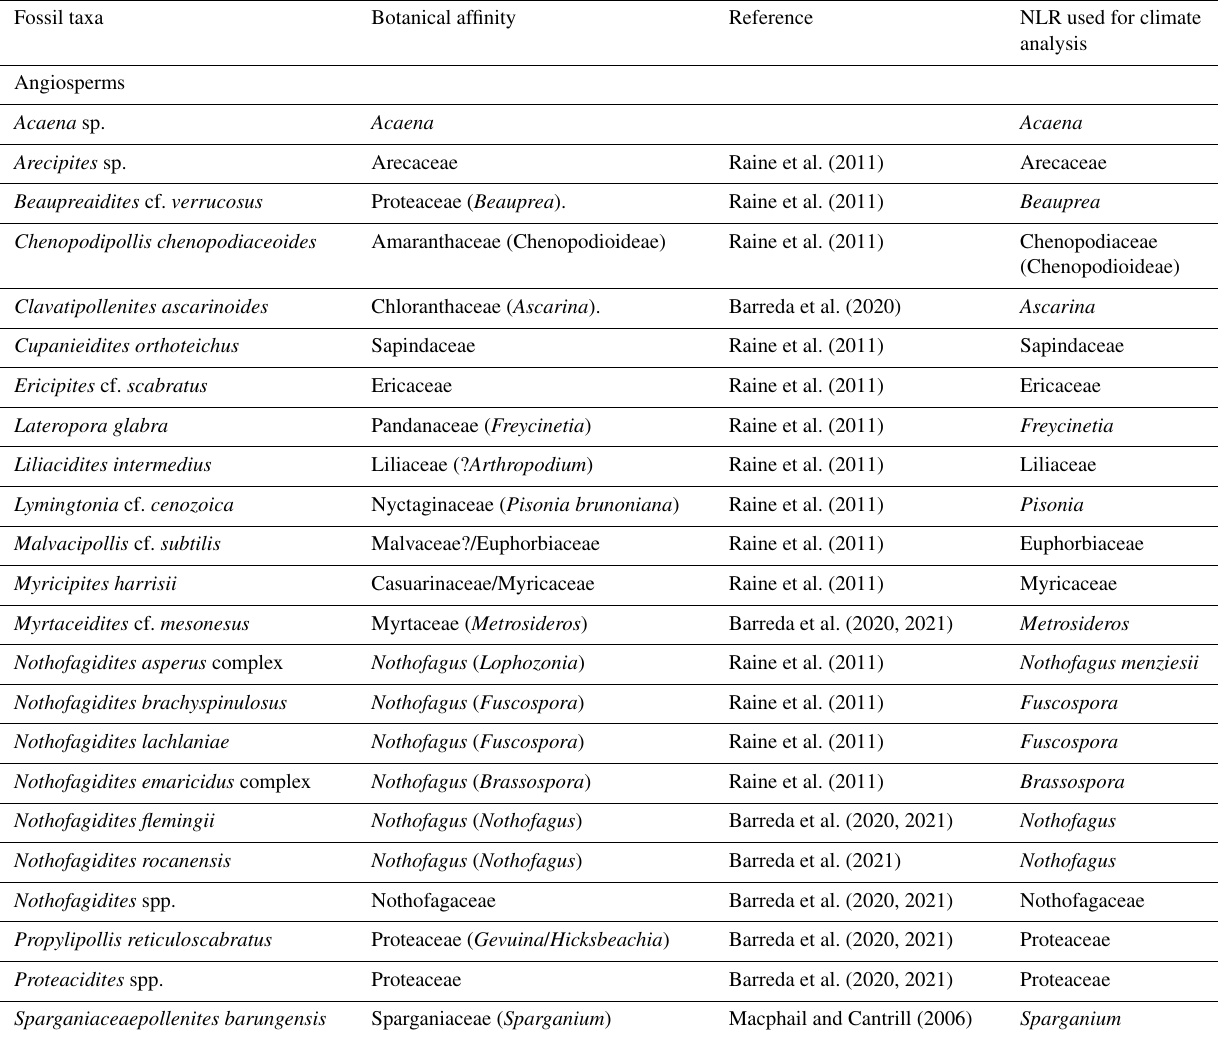
Table 2. List of fossil pollen and spore taxa and their NLR used in sporomorph-based climate estimates from ODP Site 696. Fossil